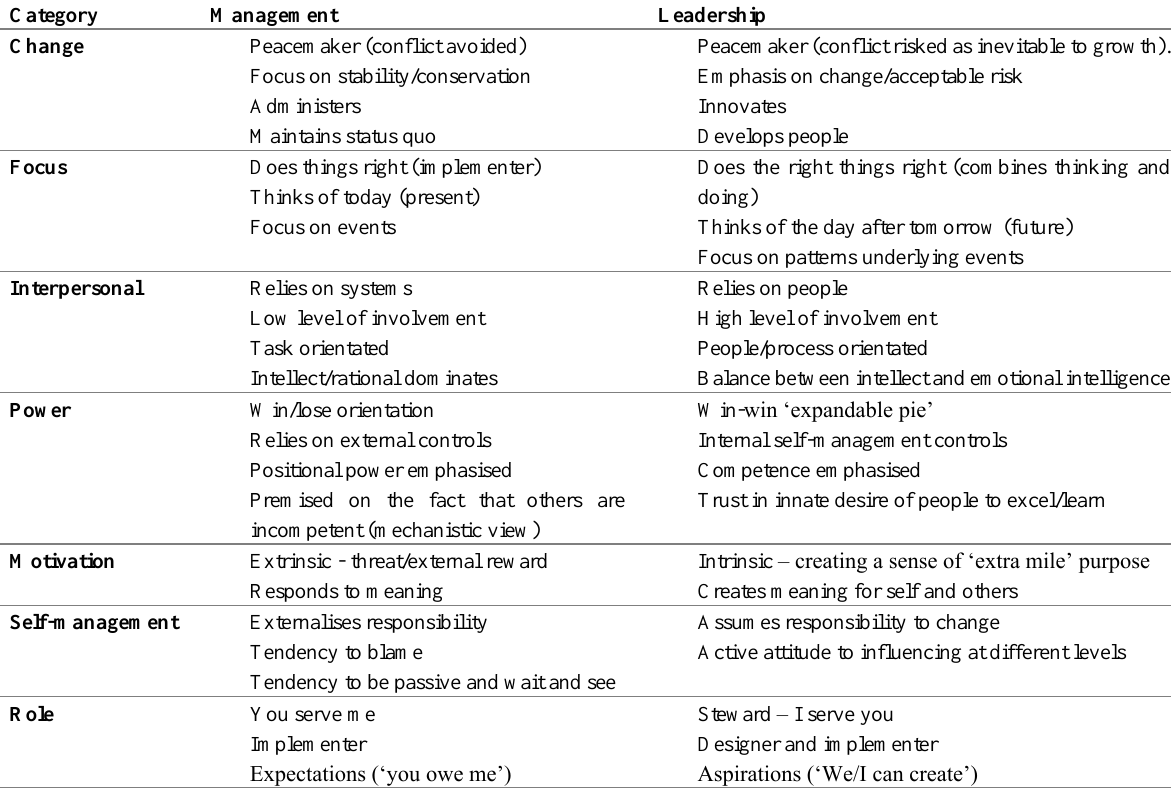
Table 1: Core difference between management and